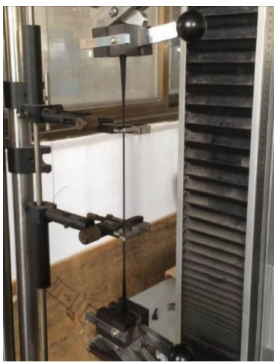
Figure 5. Tension testing machine.